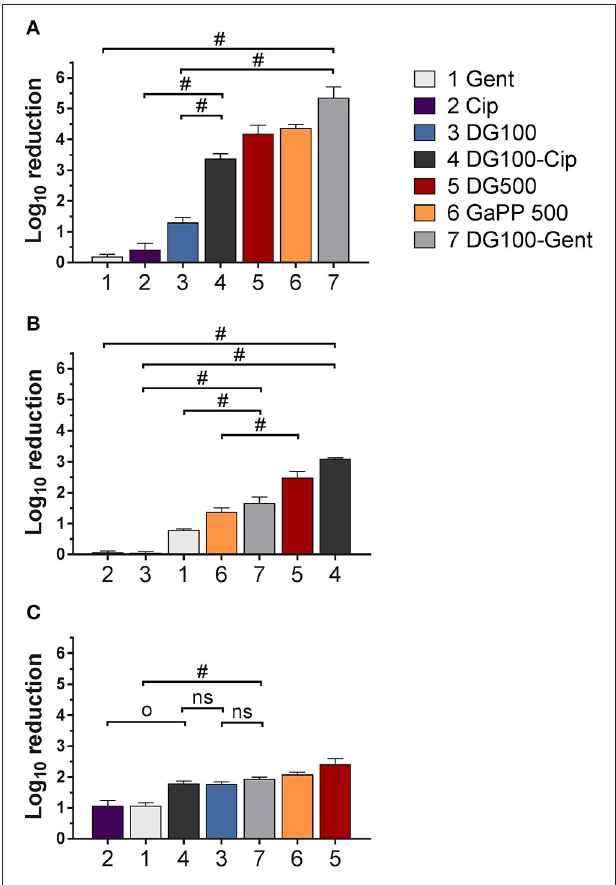
FIGURE 3 | Log 10 reduction of small colony variant SCV1 (A) , SCV2 (B) and parent strain P1 (C) colony biofilms after exposure to drug loaded hydrogels compared to untreated control. 1: Gentamicin (Gent) 100 µ g/ml (light gray), 2: Ciprofloxacin (Cip) 5 µ g/ml (purple), 3: Deferiprone (Def, 20 mM)-Gallium-protoporphyrin (GaPP) 100 µ g/ml (blue), 4: Def-GaPP100-Cip (black), 5: Def-GaPP500 (red), 6: GaPP 500 (orange), 7: Def-GaPP100-Gent (dark gray). Data represent the mean ± SD of three biological replicates. O p < 0.001; # p < 0.0001; ns-not statistically significant.